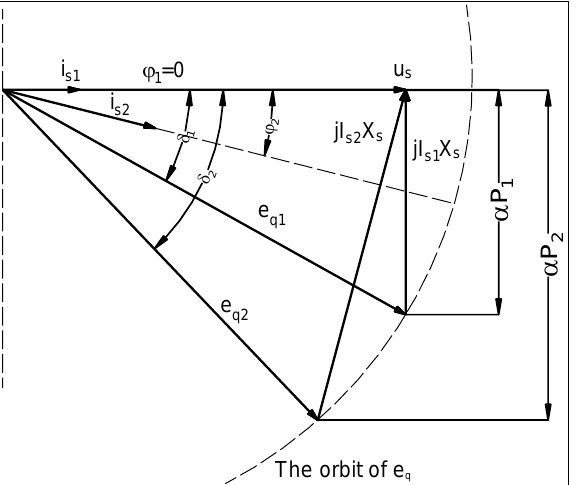
Figure 9. Vector diagram of synchronous motor when stator source and excitation source are constant, load changes from P 1 to P 2 , with P 2 > P